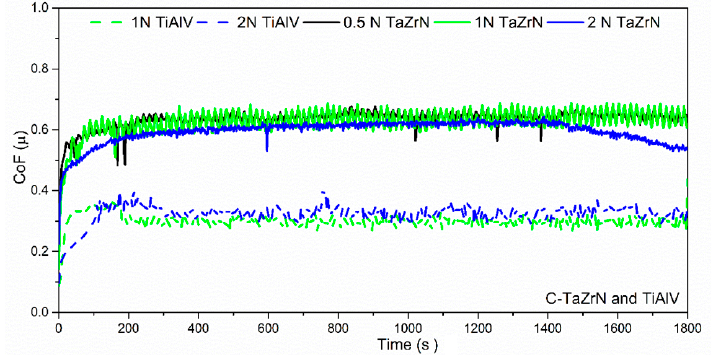
Figure 10. Friction coefficient evolution during sliding tribocorrosive tests on coated and uncoated surfaces.